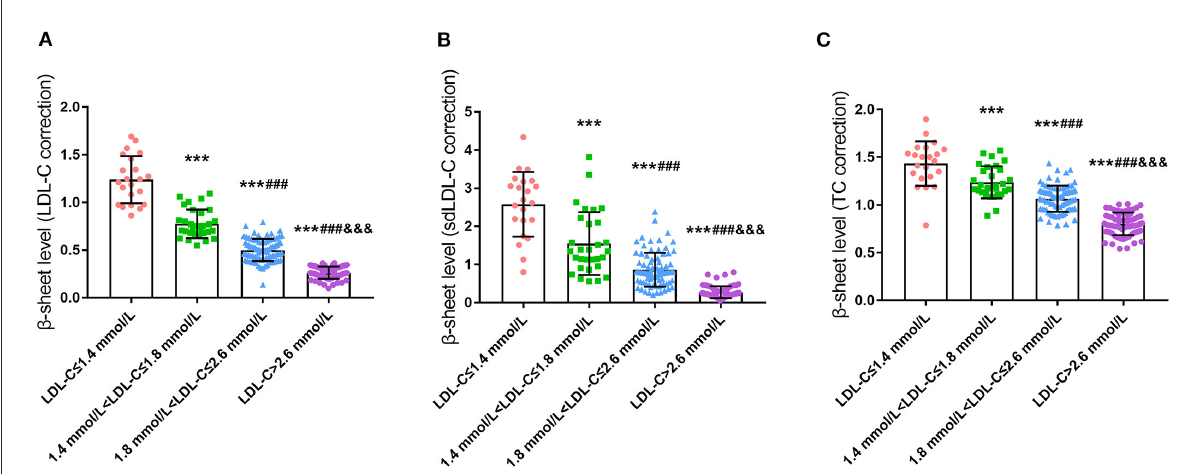
FIGURE2 Comparison of serum β -sheet levels in CHD patients with different LDL-C levels (A) , LDL-C correction; (B) , sdLDL-C correction; (C) , TC correction; *** p < 0.001 vs. LDL-C ≤ 1.4 mmol/L. ### p < 0.001 vs. 1.4 mmol/L < LDL ≤ 1.8 mmol/L. &&& p < 0.001 vs. 1.8 mmol/L < LDL ≤ 2.6 mmol/L.